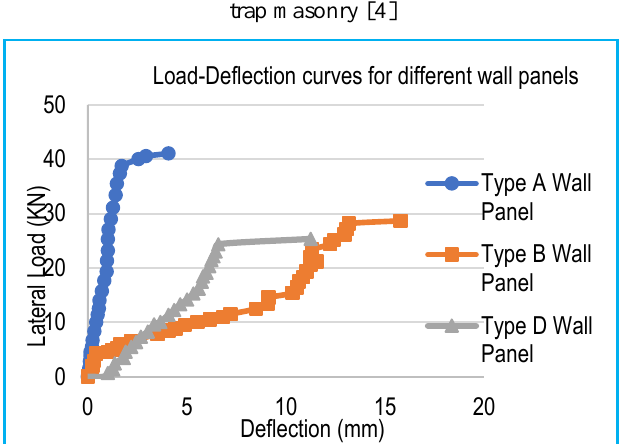
Fig. 6. Stress-strain curve of (a) English bond (b) and rat-